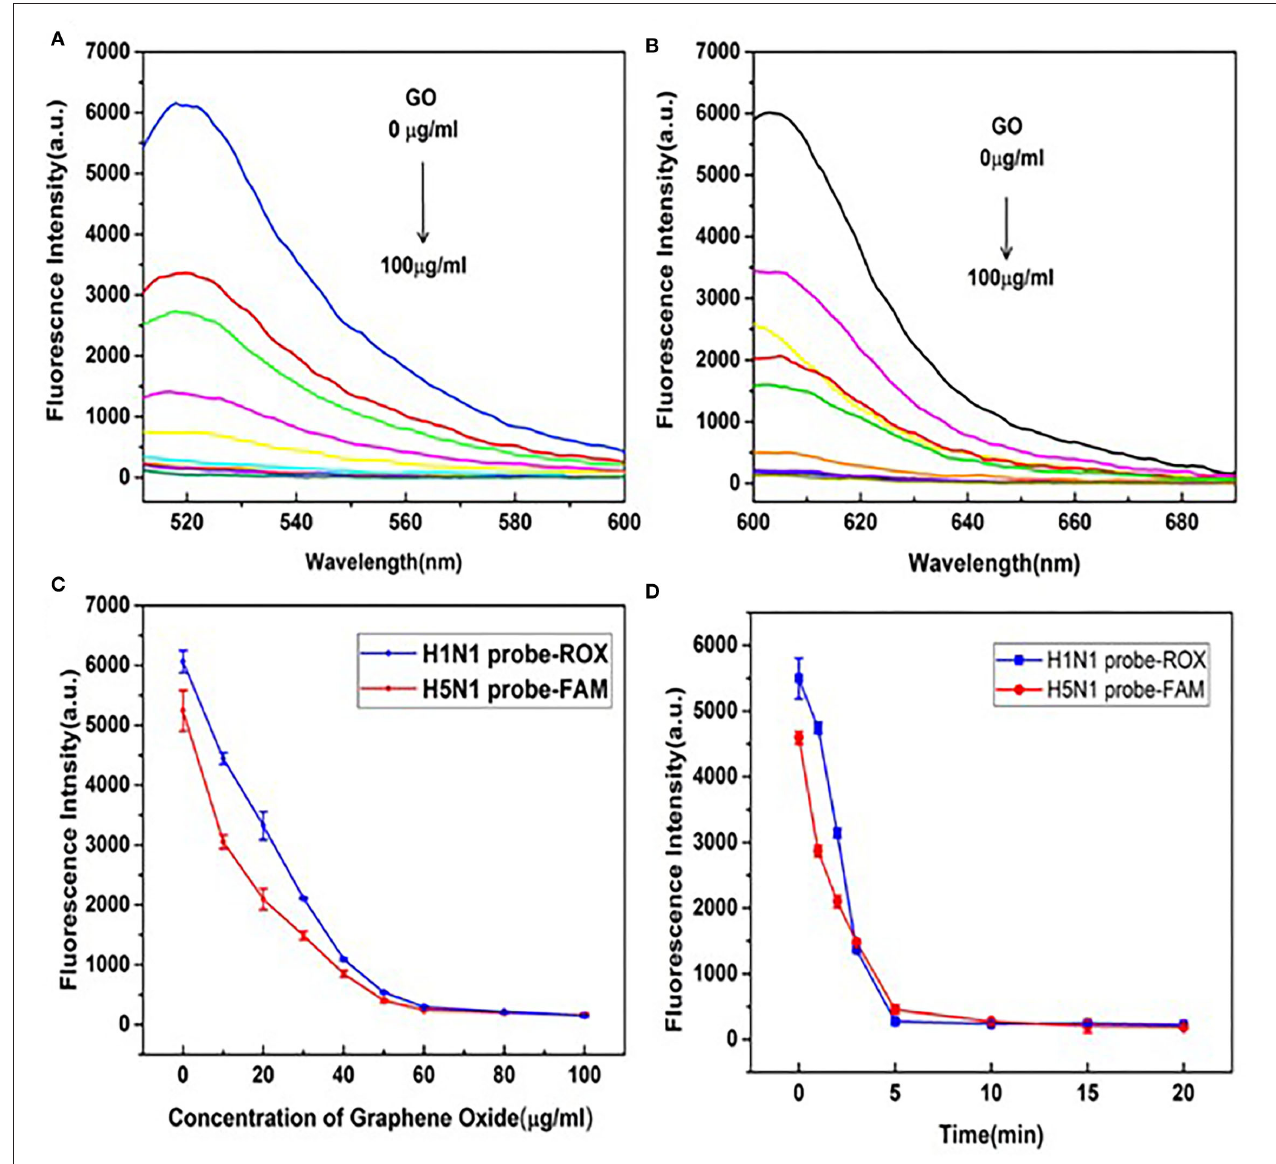
FIGURE 2 | Optimization of GO reaction conditions. (A) Fluorescence emission spectral signals of the H5N1-FAM probe. (B) H1N1-ROX probe in the presence of different concentrations of GO (0, 10, 20, 30, 40, 50, 60, 80, and 100 µ g/ml). (C) Changes in trends of fluorescence signals of H5N1-FAM and H1N1-ROX probes in the presence of different concentrations of GO (0, 10, 20, 30, 40, 50, 60, 80, and 100 µ g/ml). (D) Changes in trends of fluorescence signals at different time points (0, 1, 2, 3, 5, 10, 15, and 20min) in the presence of GO (50 µ